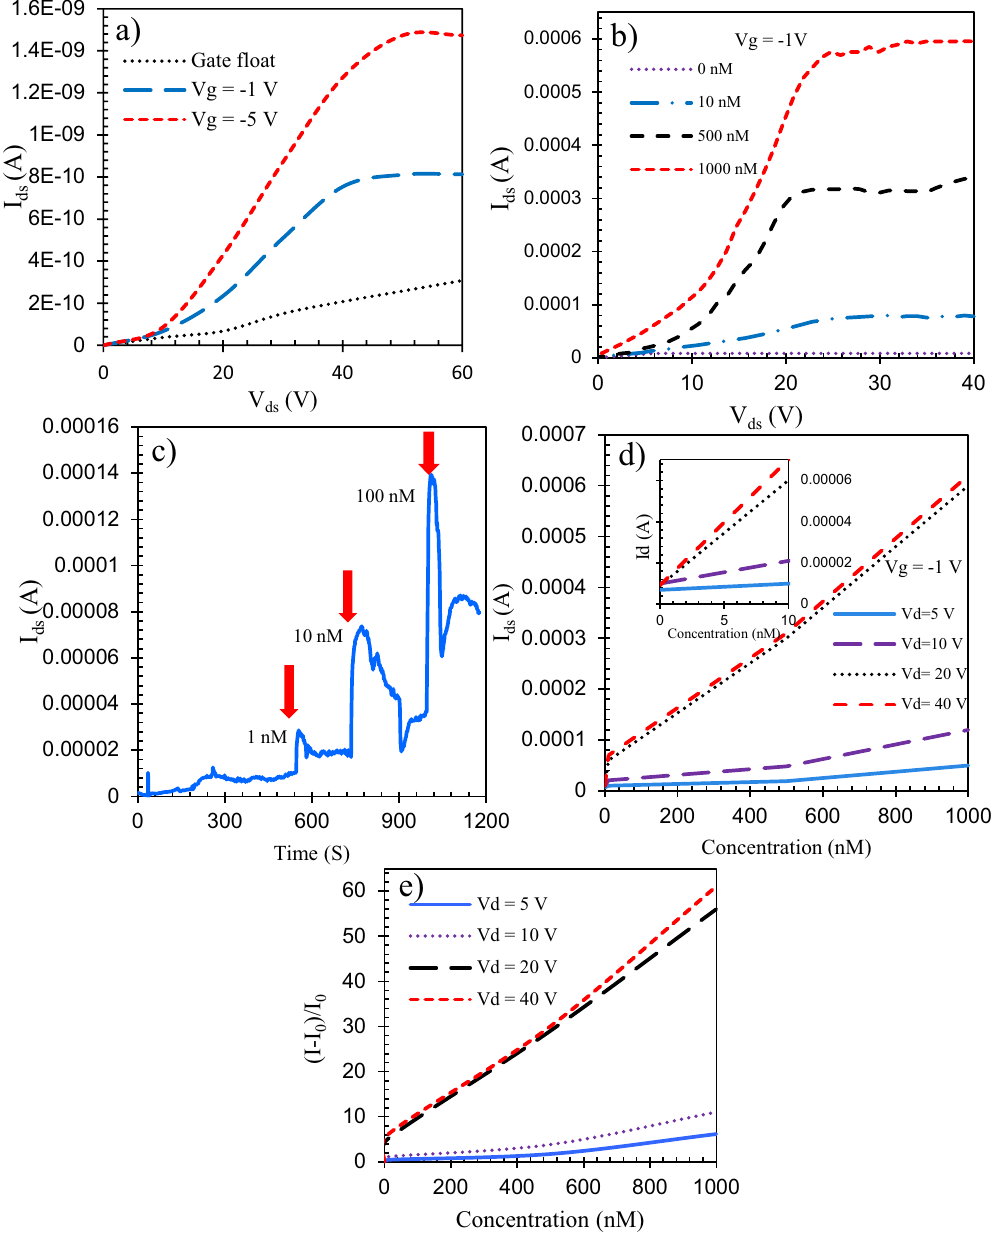
Figure 12. ( a ) I ds as a function of V ds without glucose for different gate voltages. ( b ) I ds as a function of V ds for different glucose concentrations including very low concentrations. ( c ) The very fast response of the sensor to the variations of glucose concentrations. ( d ) I ds as a function of glucose concentrations for different drain voltages. ( e ) The relative current change as a function of glucose concentrations for different drain voltages.